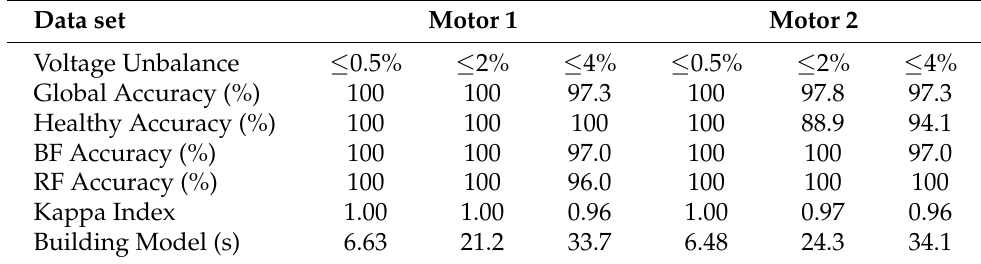
Table 6. Experimental results using the 450 SMI attributes among i a , i b and i c —Multi-fault identification.